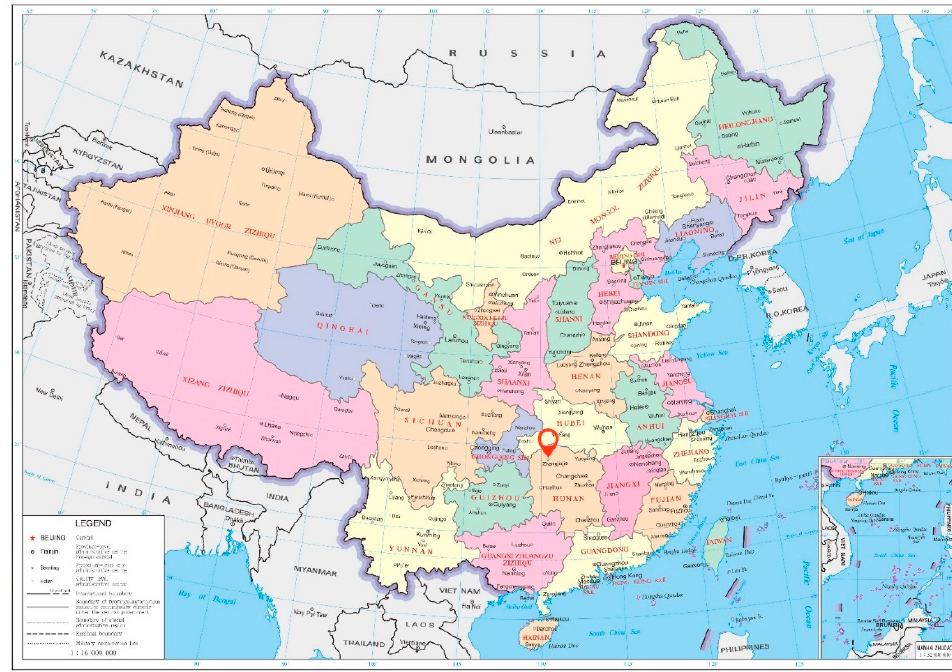
Figure 2. The location of the experimental site.